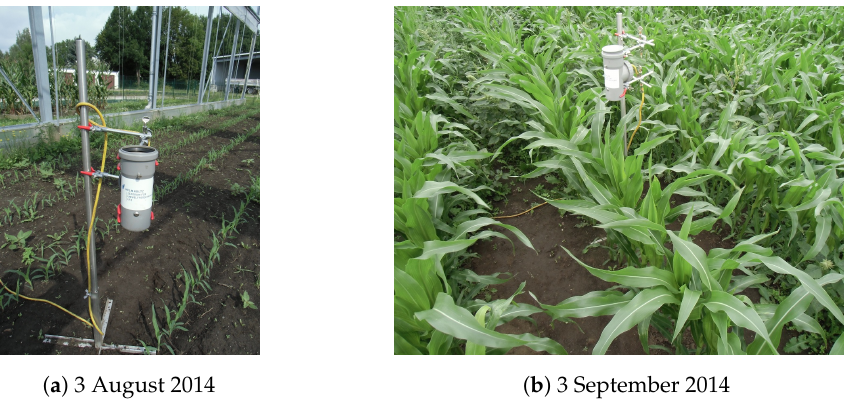
Figure 10. Installation of the Lytro LF and experimental setup in the field at the Global Change Experimental Facility project (GCEF) test site. ( a ) Shows the tripod and housing of the Lytro LF at the beginning of the experiment, whereas ( b ) shows the situation at the end of the field campaign.